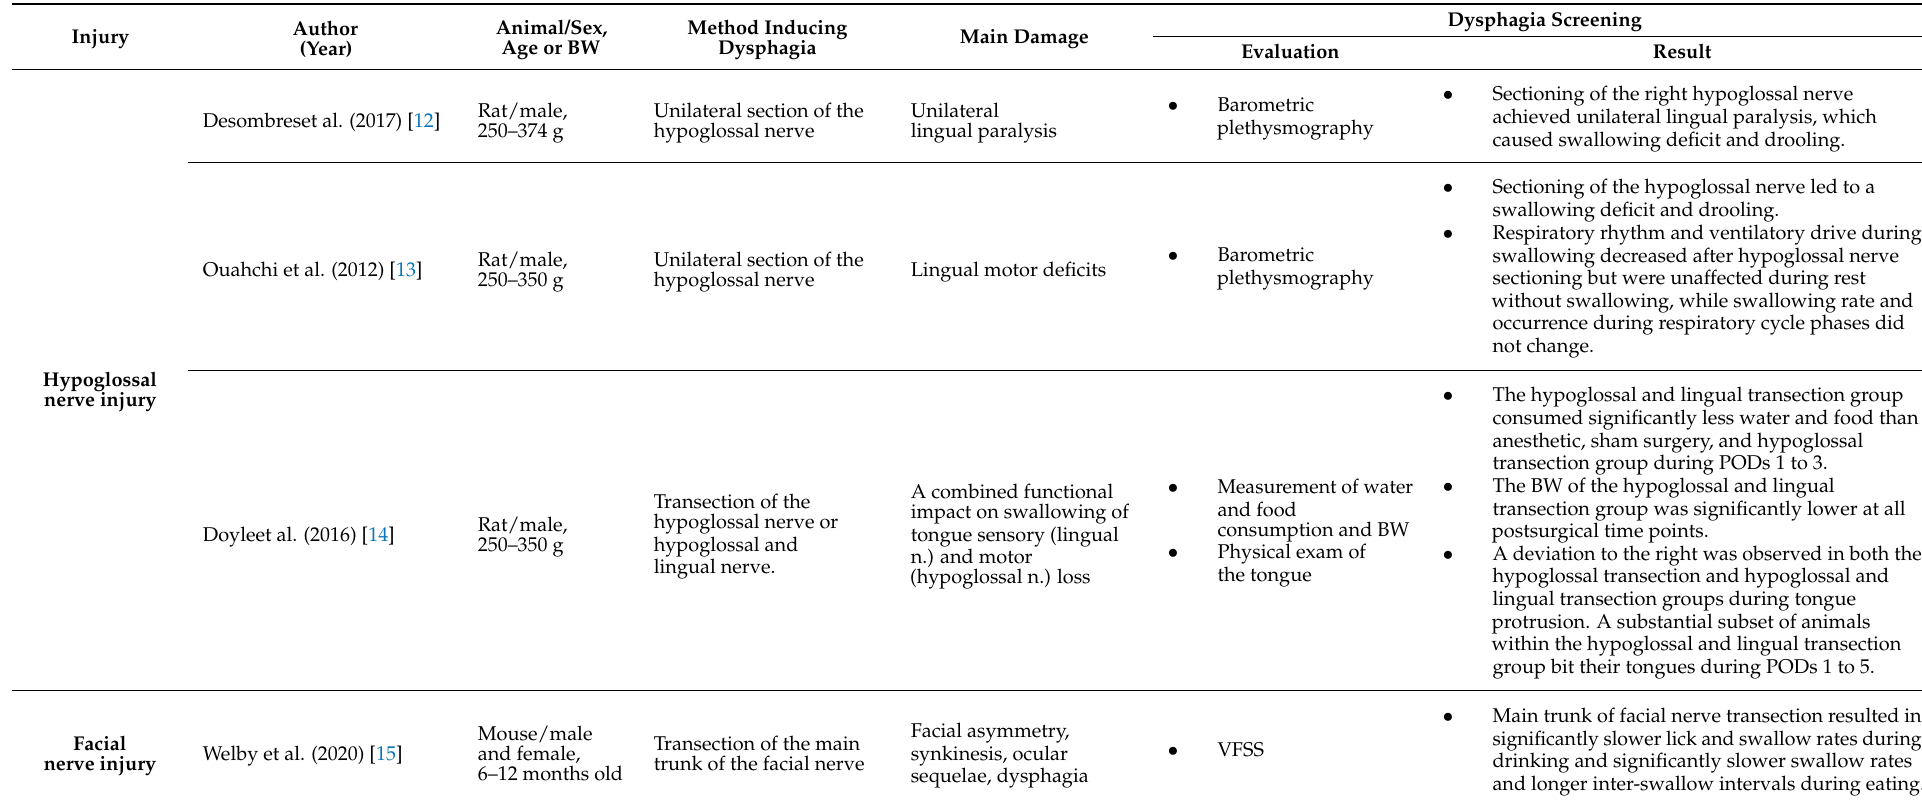
Table 1. Characterization of oropharyngeal dysphagia in rodent models of lingual and facial muscles